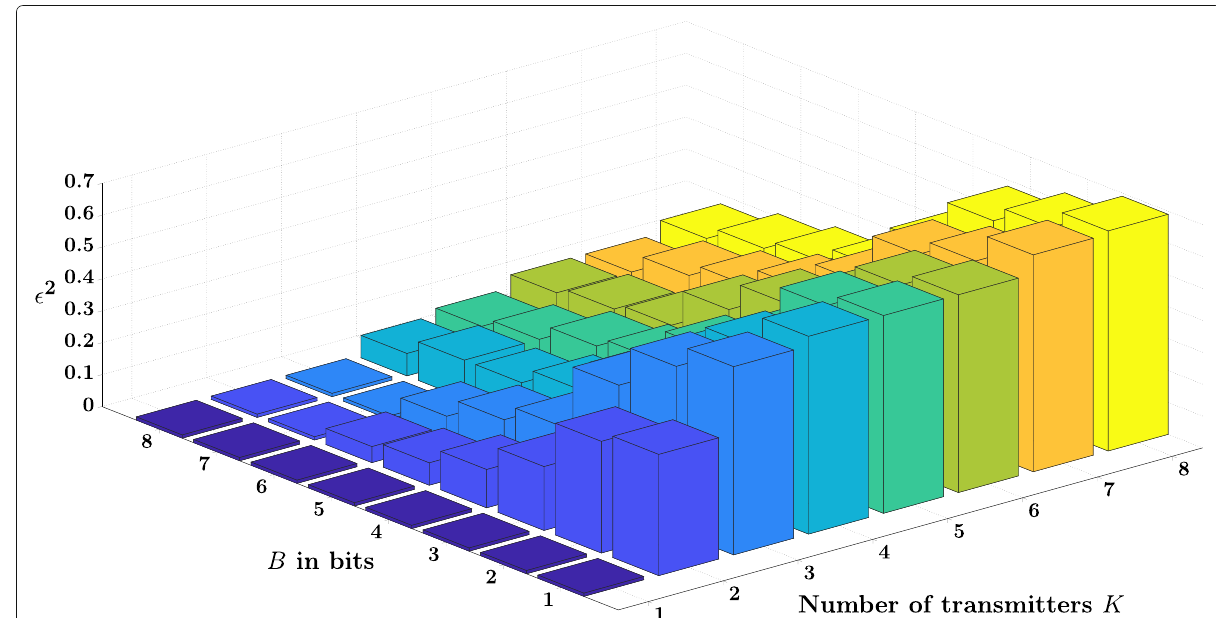
Fig. 3 Error Database Example. An example of the offline database saved at each node where (cid:5) can be chosen as a function of K , B , and Pr o . In this example, Pr o is set to 5%